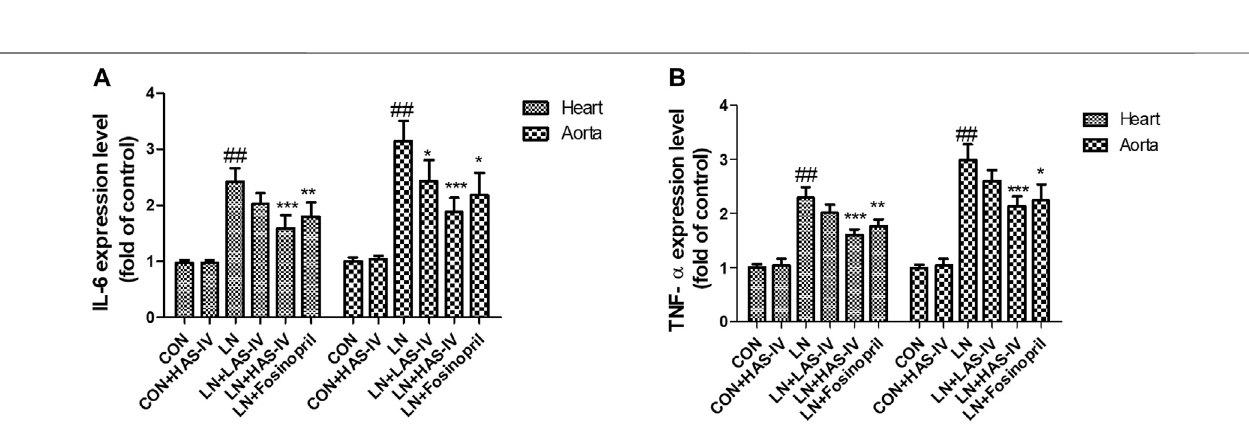
FIGURE 8 | Effects of Astragaloside IV (AS-IV) on in fl ammation biomarkers in hypertensive rats evoked by L-NAME. The mRNA expression levels of IL-6 (A) and TNF- α (B) in CON, CON + HAS-IV, LN, LN + LAS-IV, LN + HAS-IV and LN + fosinopril groups. Results were shown as mean ± SD ( n (cid:1) 6 for each group). ## p < 0.001 versus CON group, * p < 0.01 versus LN group; ** p < 0.01 versus LN group; *** p < 0.001 versus LN group.